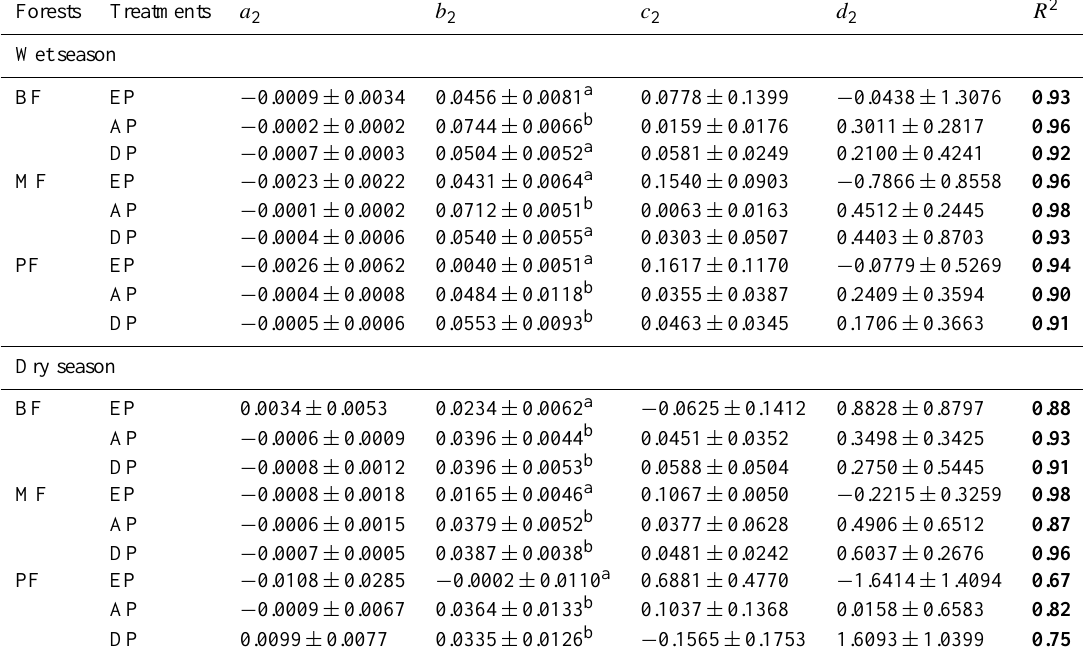
Table 5. Relationships of soil respiration (µmolCO 2 m − 2 s − 1 ) with soil temperature ( ◦ C) and soil moisture (%vol.) using a combined exponential and quadratic function ( R = (a 2 M 2 + c 2 M + d 2 ) exp (b 2 T ) , where R is soil respiration, T is soil temperature, M soil moisture, and a 2 , b 2 , c 2 and d 2 the functional coefficients; especially the b 2 value can be directly considered as the parameter related to the temperature sensitivity of soil respiration) under different seasons and precipitation treatments at the DNR forests (parameter estimate ± standard error). The treatments are as follows: precipitation exclusion (EP), ambient precipitation (AP), and double precipitation (DP). The forests are as follows: broadleaf forest (BF), mixed forest (MF), and pine forest (PF). R 2 is the coefficient of determination. Numbers in bold indicate the level of function fitting is significant ( p < 0 . 05). Different superscripted letters in each forest site within a column denote significant difference ( p < 0 . 05) among precipitation